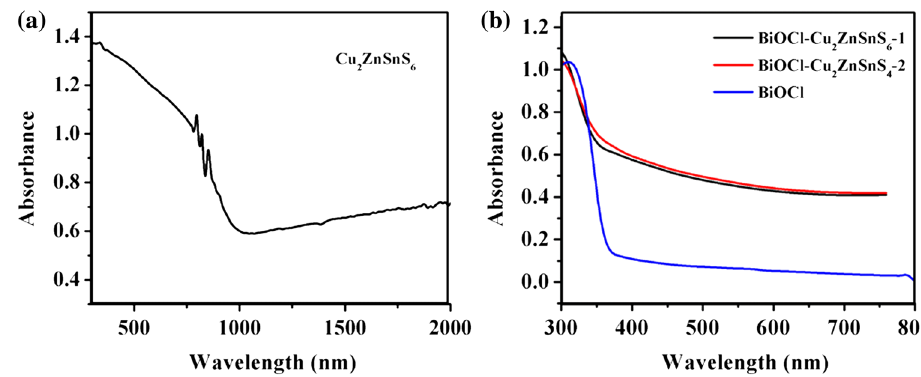
Fig. 4 UV–visible light-NIR absorption spectrum of BiOCl microspheres, BiOCl–Cu 2 Zn-